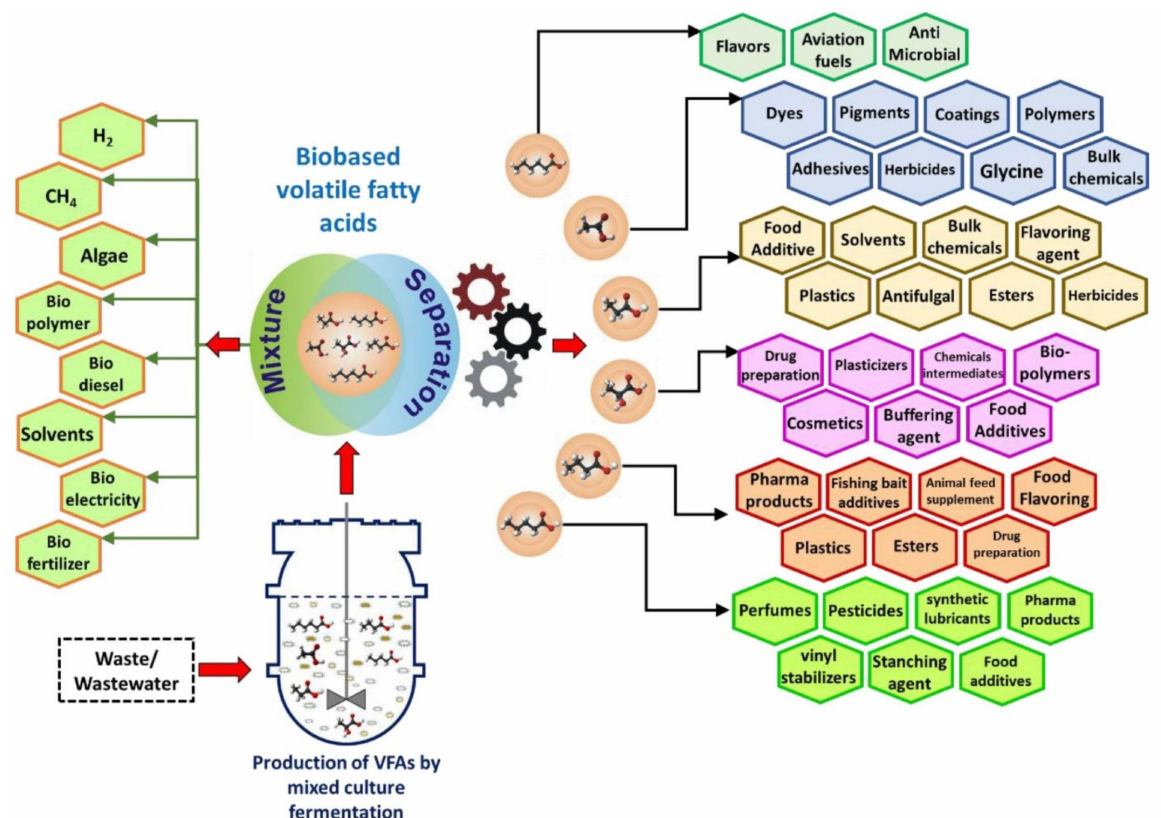
Figure 1. Scope and application of bio-based volatile fatty acids, figure taken from